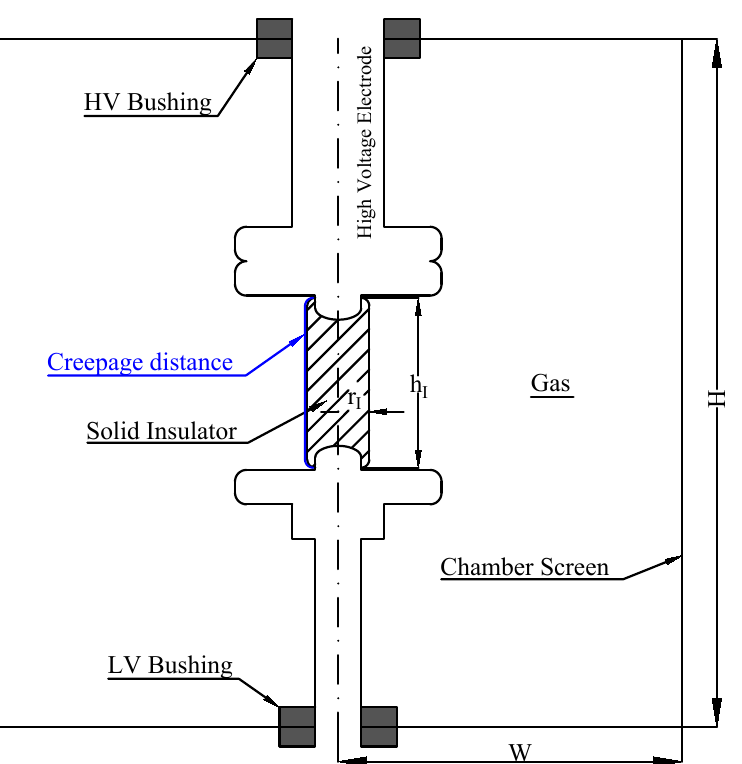
Figure 2. Mockup of solid-gas chamber used for the HVDC-GIS electric field modelling in air. The creepage distance, i.e., the distance between HV and LV electrodes along the insulator surface, is highlighted in